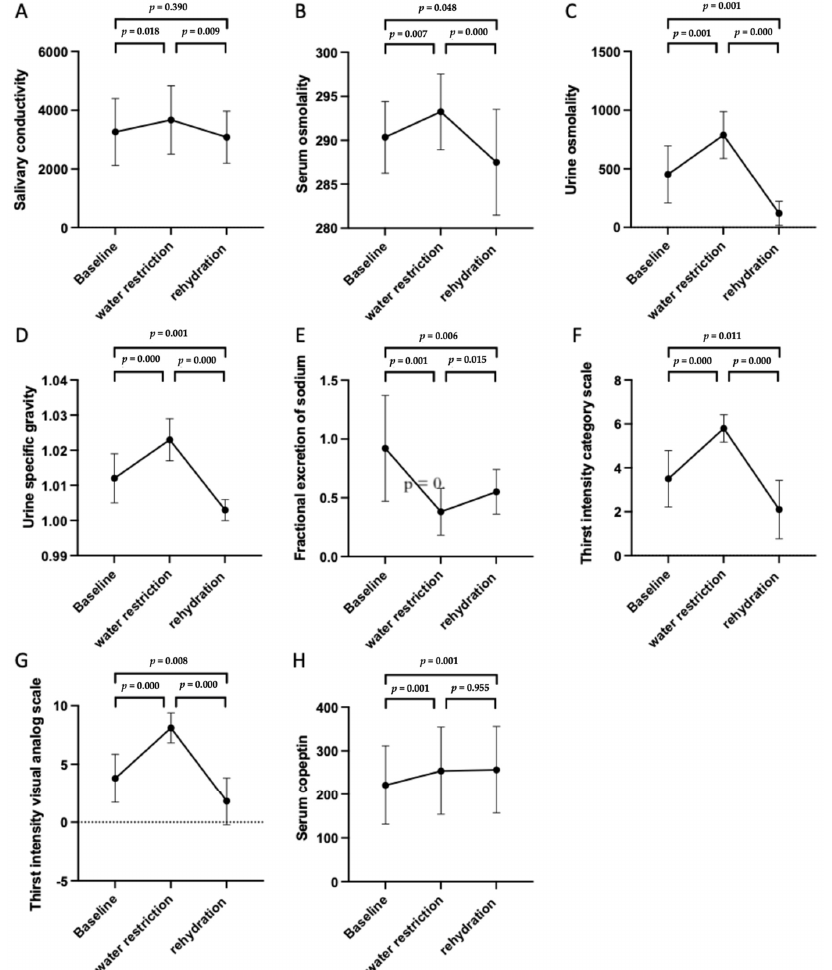
Figure 3. Changes in different biomarkers and parameters for evaluation of fluid status. The changes in the different biomarkers are shown with polygonal line graphs (n = 20), including salivary conductivity ( A ), serum osmolality ( B ), urine osmolality ( C ), urine specific gravity ( D ), fractional excretion of sodium ( E ), thirst intensity category scale ( F ), thirst intensity visual analog scale ( G ), and serum copeptin ( H ). Note: The black dots and error bars indicate the mean and standard deviation of the biomarkers. The p -values between two different fluid statuses are labeled in each figure.